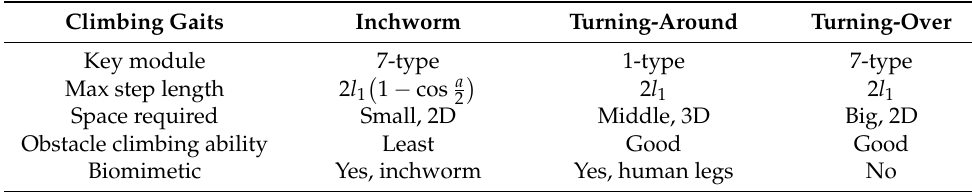
Table 1. Features of the three climbing gaits.